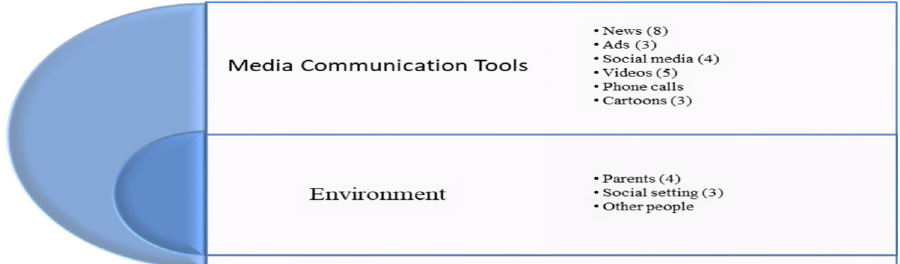
Figure 4: Causes of Children’s Reaction to the